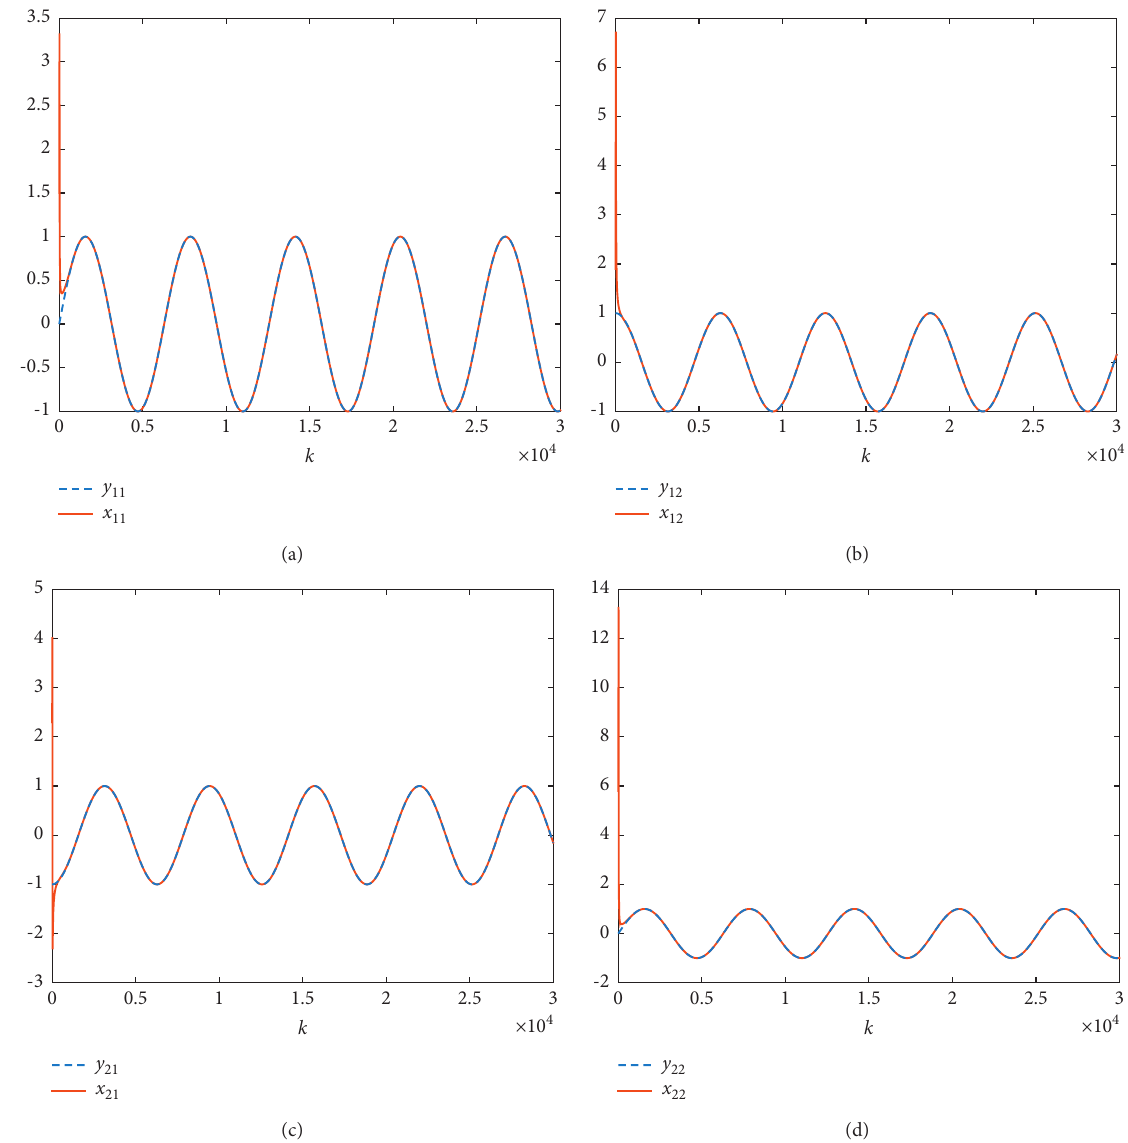
Figure 2: Solution trajectories synthesized by Y c � 5 . 0). (a) Trajectories of y